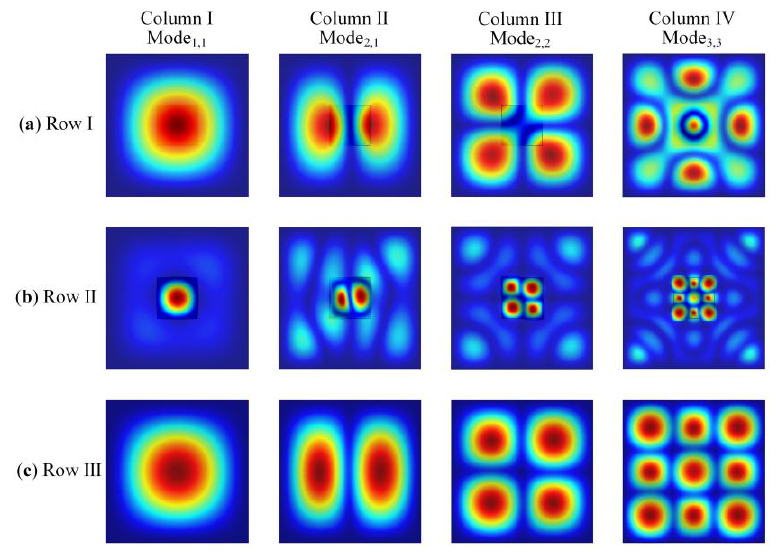
Figure 2. COMSOL Multiphysics modal simulations for the single-element DFUT, ( a ) at the CMUT operation mode; ( b ) at the PMUT operation mode; ( c ) for the referenced conventional CMUT.